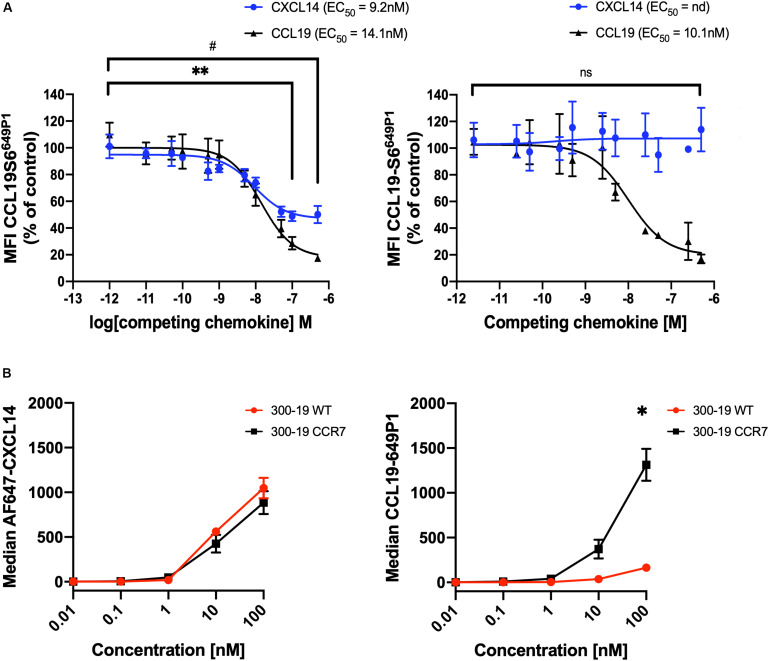
CXCL14 interferes with CCL19 internalization. (A) CXCL14 interaction with CCR7 was determined indirectly in competition binding assays with fluorescently labeled CCL19 (CCL19Dy649P1) by flow cytometry. 300-19-CCR7 cells were incubated with 25 nM of CCL19Dy649P1 in the presence of increasing concentrations of unlabeled human CCL19 or CXCL14 at 37°C (left panel) or 10°C (right panel). Competition is displayed as a decrease in mean fluorescence intensity (non-linear regression applied) of the cell-associated labeled chemokine in comparison to untreated cells. EC50, concentration giving half-maximal inhibition. Data shown are means + SEM of 3–4 independent experiments. ∗∗P < 0.01 comparing CXCL14 addition to untreated cells, #P < 0.05 comparing CCL19 addition to untreated cells, using Wilcoxon test. (B) Binding of increasing concentrations of AF647-CXCL14 (left panel) and CCL19Dy649P1 (right panel) to 300-19-WT or 300-19-CCR7 was determined by flow cytometry. Data shown are means ± SD of 3 independent experiments. ∗P < 0.05 compared to 0 nM using Holm-Sidak test.